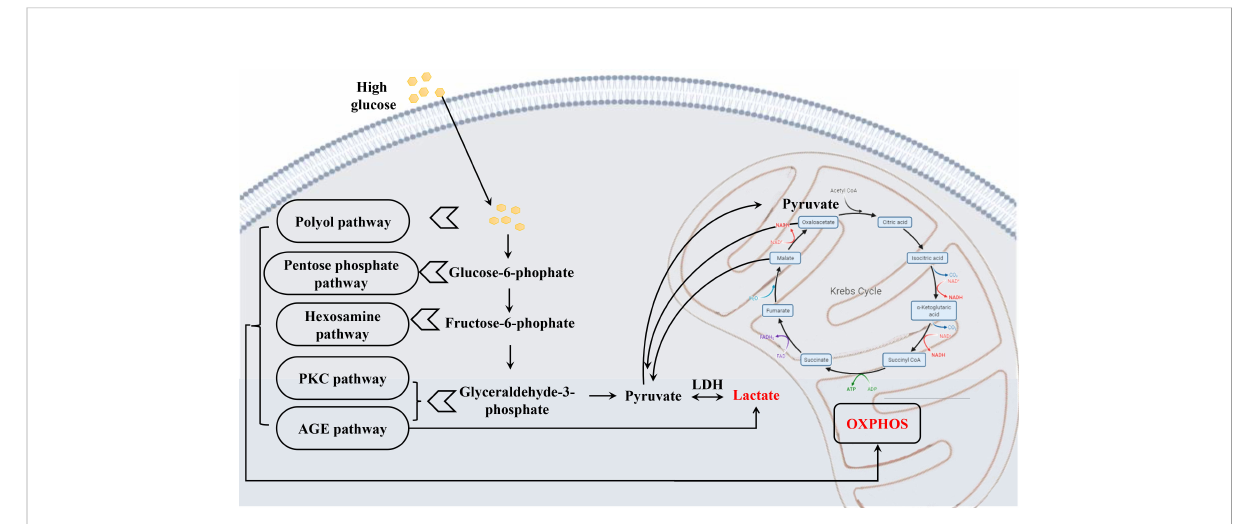
FIGURE 8 Schematic diagram depicting the metabolic alterations in early DR. Chronic hyperglycemia leads to a series of altered metabolism, the glucose metabolism most affected, causing abnormal levels of pyruvate and lactate, which results in extensive oxidative stress, and fi nally damaging the